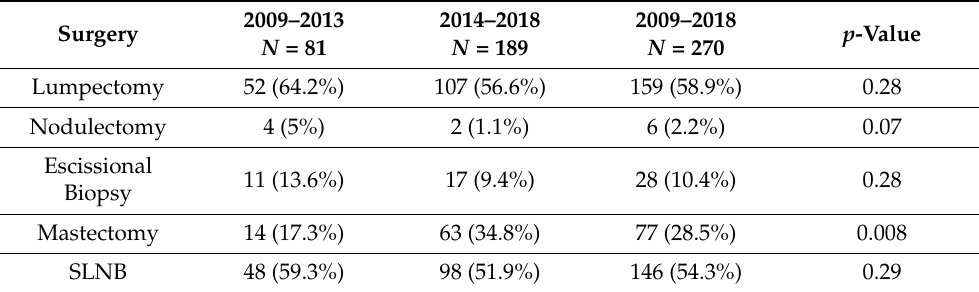
Table 2. Surgical treatments performed.